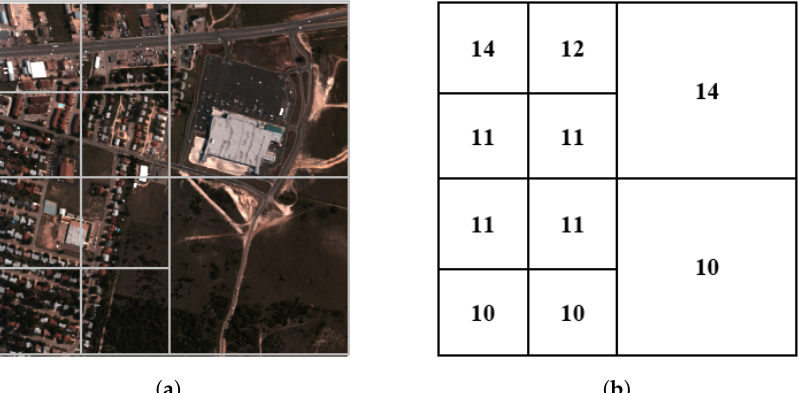
Figure 31. ( a ) quadtree image segmentation of the Urban scene; ( b ) number of endmembers per tile (total =